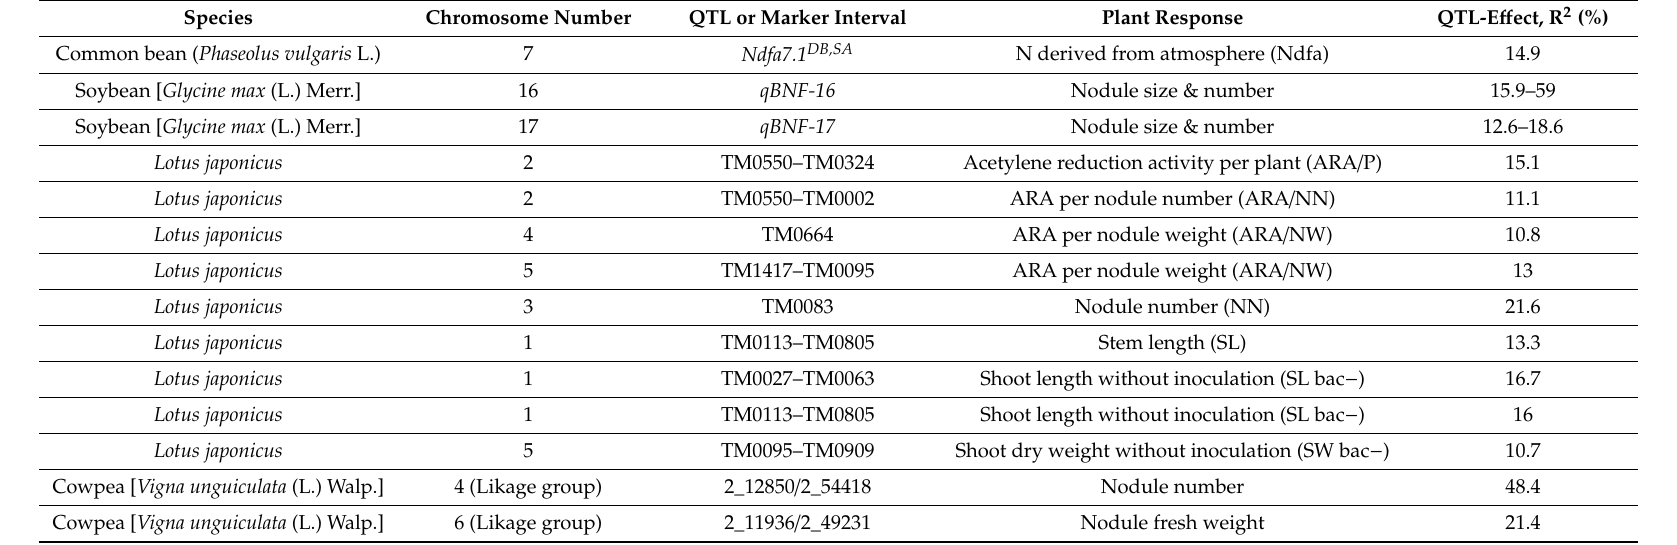
Table 1. Major genomic loci detected for BNF in di ff erent legume species [66–69]. Species Chromosome Number QTL or Marker Interval Plant Response QTL-E ff ect, R 2 (%) Common bean ( Phaseolus vulgaris L.) 7 Ndfa7.1 DB,SA N derived from atmosphere